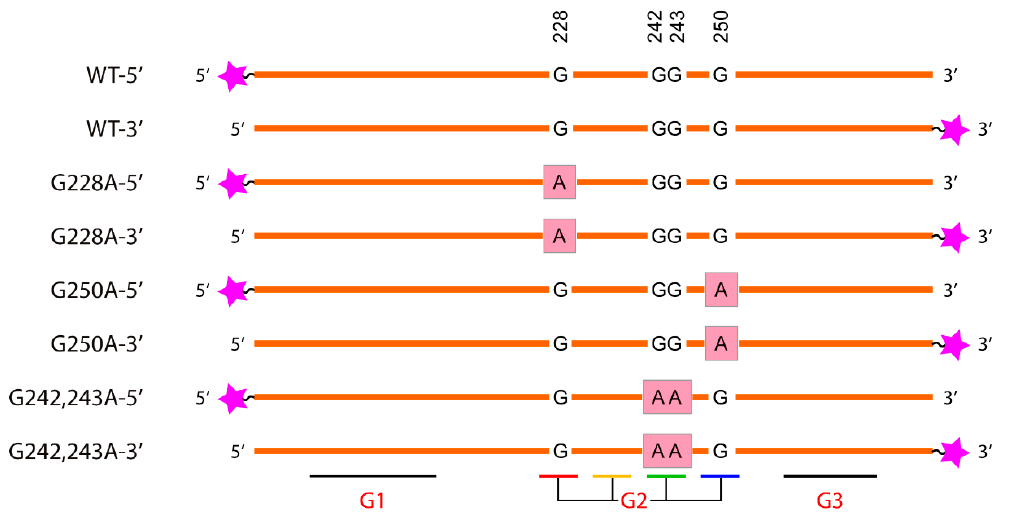
Figure 3. Schematic representation of a single ‐ stranded 96 ‐ nt DNA fragment of the WT hTERT promoter (designated as WT ‐ 5 ′ or WT ‐ 3 ′ depending on the position of the TAMRA fluorophore) and its altered versions containing the G228A substitution (G228A ‐ 5 ′ or G228A ‐ 3 ′ ), the G250A mutation (G250A ‐ 5 ′ or G250A ‐ 3 ′ ), and double substitutions G242A/G243A (G242,243A ‐ 5 ′ or G242,243A ‐ 3 ′ ). Pink asterisks denote TAMRA attached to the 5 ′‐ or 3 ′‐ ends of the designed oligonucleotides. The schematic arrangement of G>A substitutions within the G ‐ tracts is mapped below.